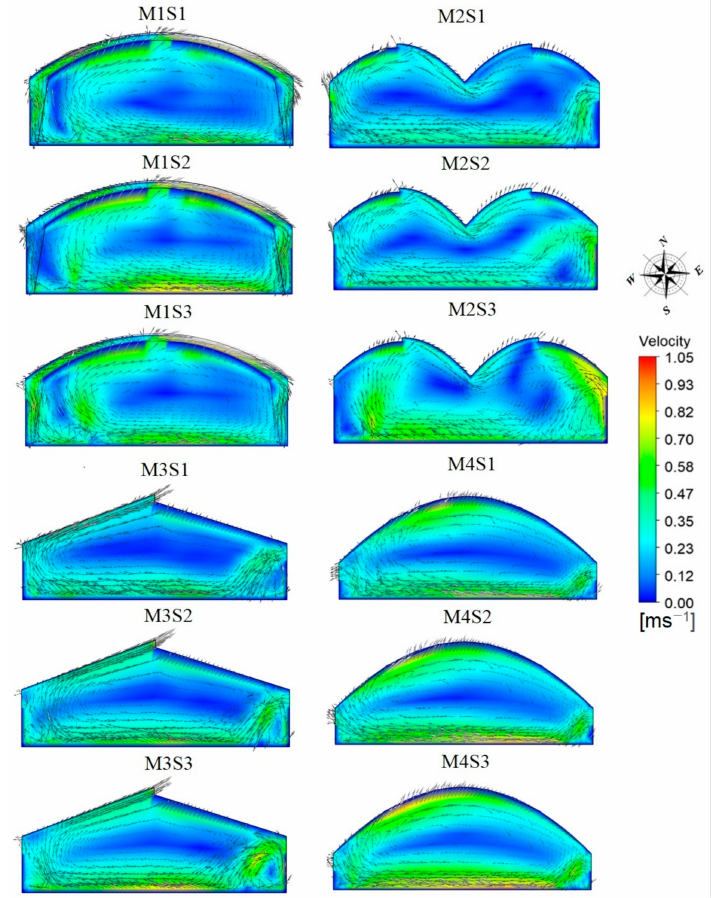
Figure 5. Spatial distribution and velocity of the simulated flow patterns (ms − 1 ), for each of the scenarios